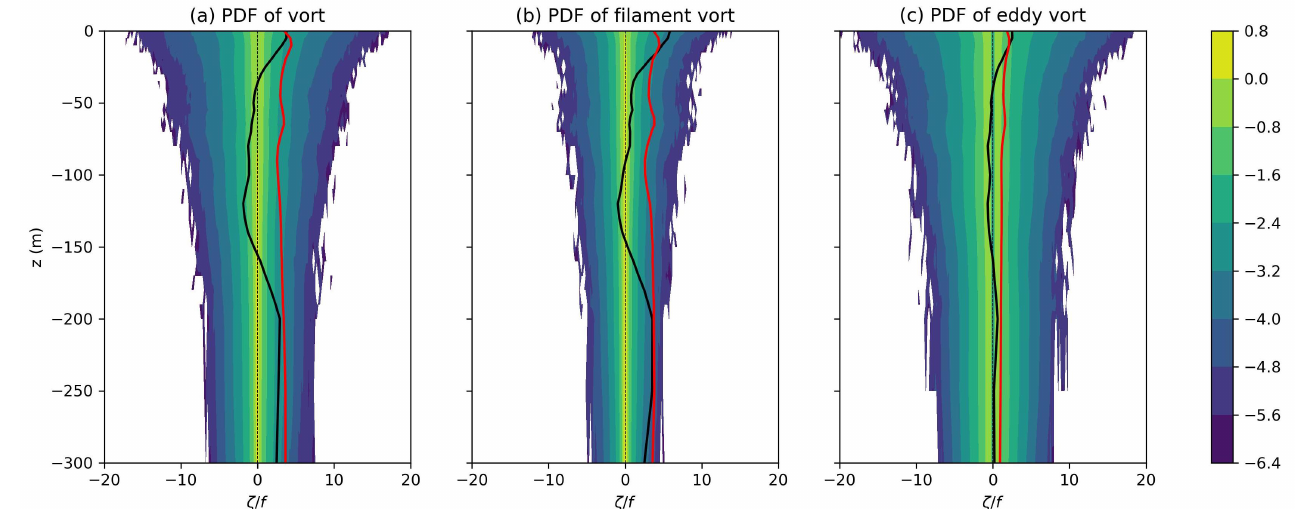
Figure 7. ( a ) Isocontours of log p ( ζ / f , z ) for: ( a ) time-averaged total vorticity and ( b , c ) time-averaged relative vorticity related to the eddies (filaments), with p ( ζ / f , z ) as the PDF of ζ / f as a function of depth. The two superimposed curves are the skewness (black) multiplied by five and the kurtosis divided by six (red) for ζ / f , respectively.